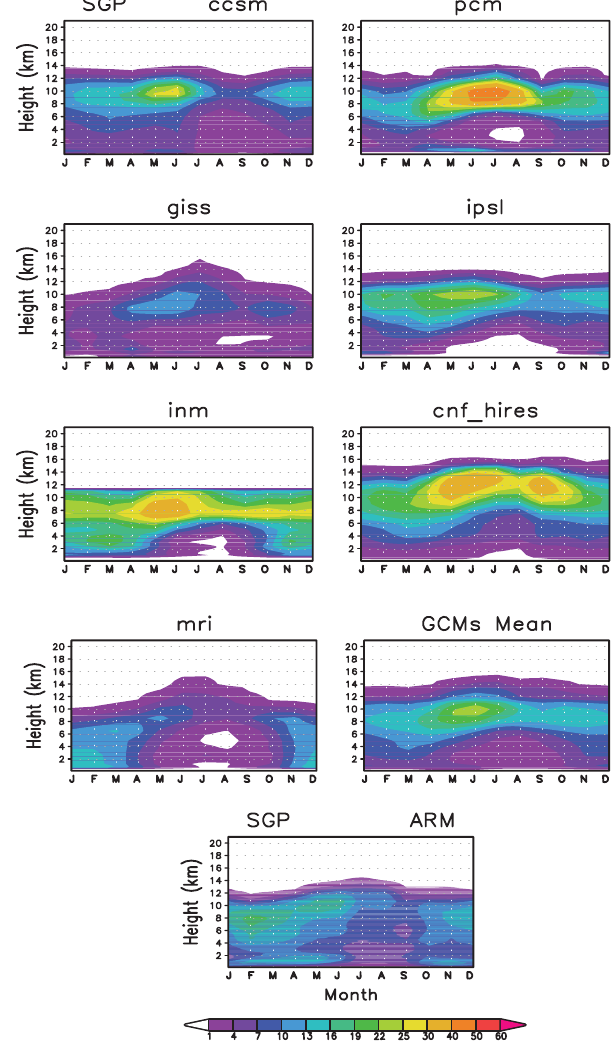
Fig. 12. Same as for Fig. 10, but for